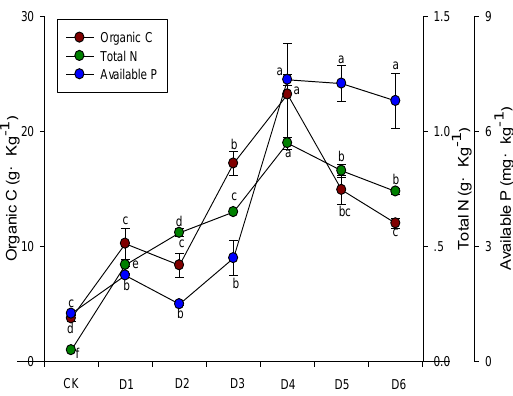
Figure 12. Relationship between poplar density and soil chemical indexes. Means with different letters indicate significant differences at p < 0.05. Vertical bars represent ± standard deviation.